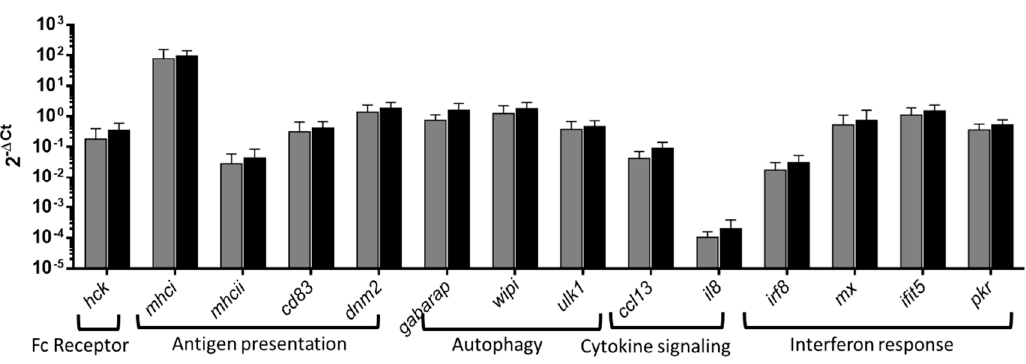
Figure 5. The RT-qPCR analysis of the overrepresented pathways. PB-RBCs were purified from rainbow trout immunized with GVHSV (black bars) or TFP1 (gray bars) at 14 dpi. Gene expression was evaluated by RT-qPCR. Data are displayed as mean ± standard deviation (SD) ( n = 6). The ef1 α gene was used as an endogenous control. The Mann–Whitney test was performed to compare PB- RBCs between GVHSV- and TFP1-injected